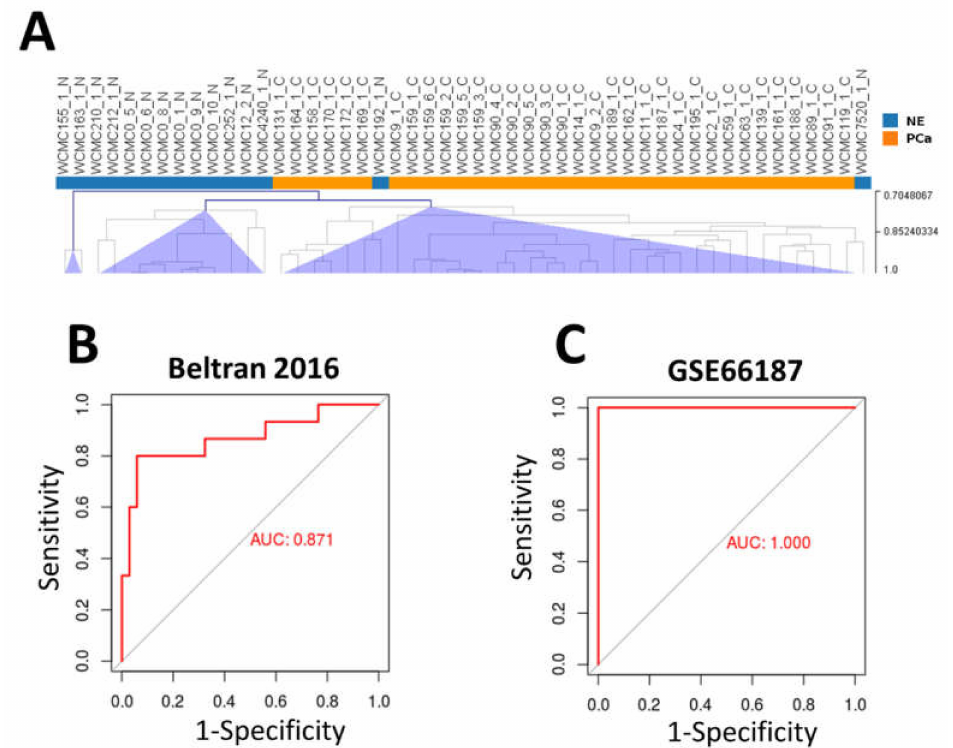
Figure 6. ( A ) Unsupervised hierarchical clustering on 15 CRPC-NE and 34 CRPC-Adeno samples from Beltran et al. [4], using the list of up- and down-regulated genes identified in our cohort of NE-like vs. AdenoPCa samples. Pearson correlation as distance metric and average linkage method were used. ( B , C ) Receiver operating characteristic (ROC) curve of the score tested on Beltran dataset ( B ) and on GSE66187 dataset ( C